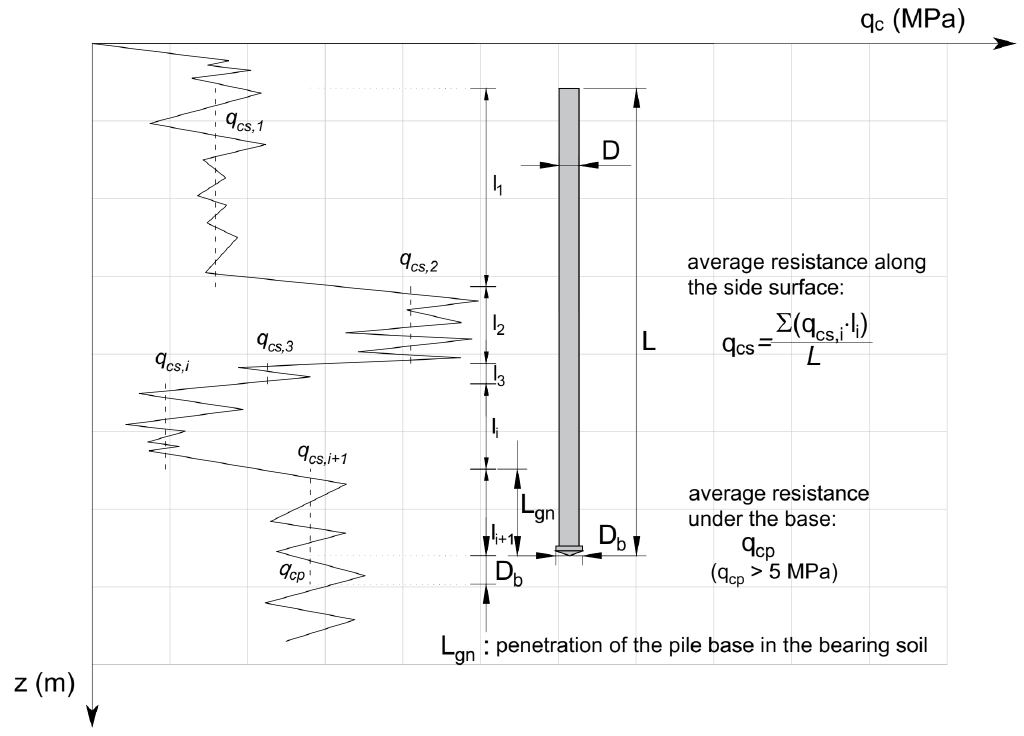
Figure 3: Template of averaging resistance from CPT